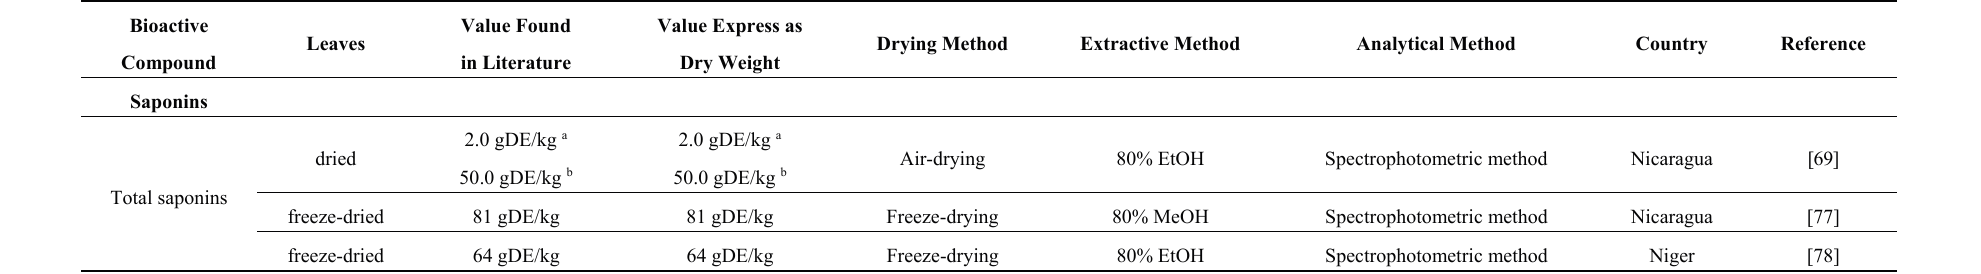
Table 8. Saponins content in Moringa oleifera